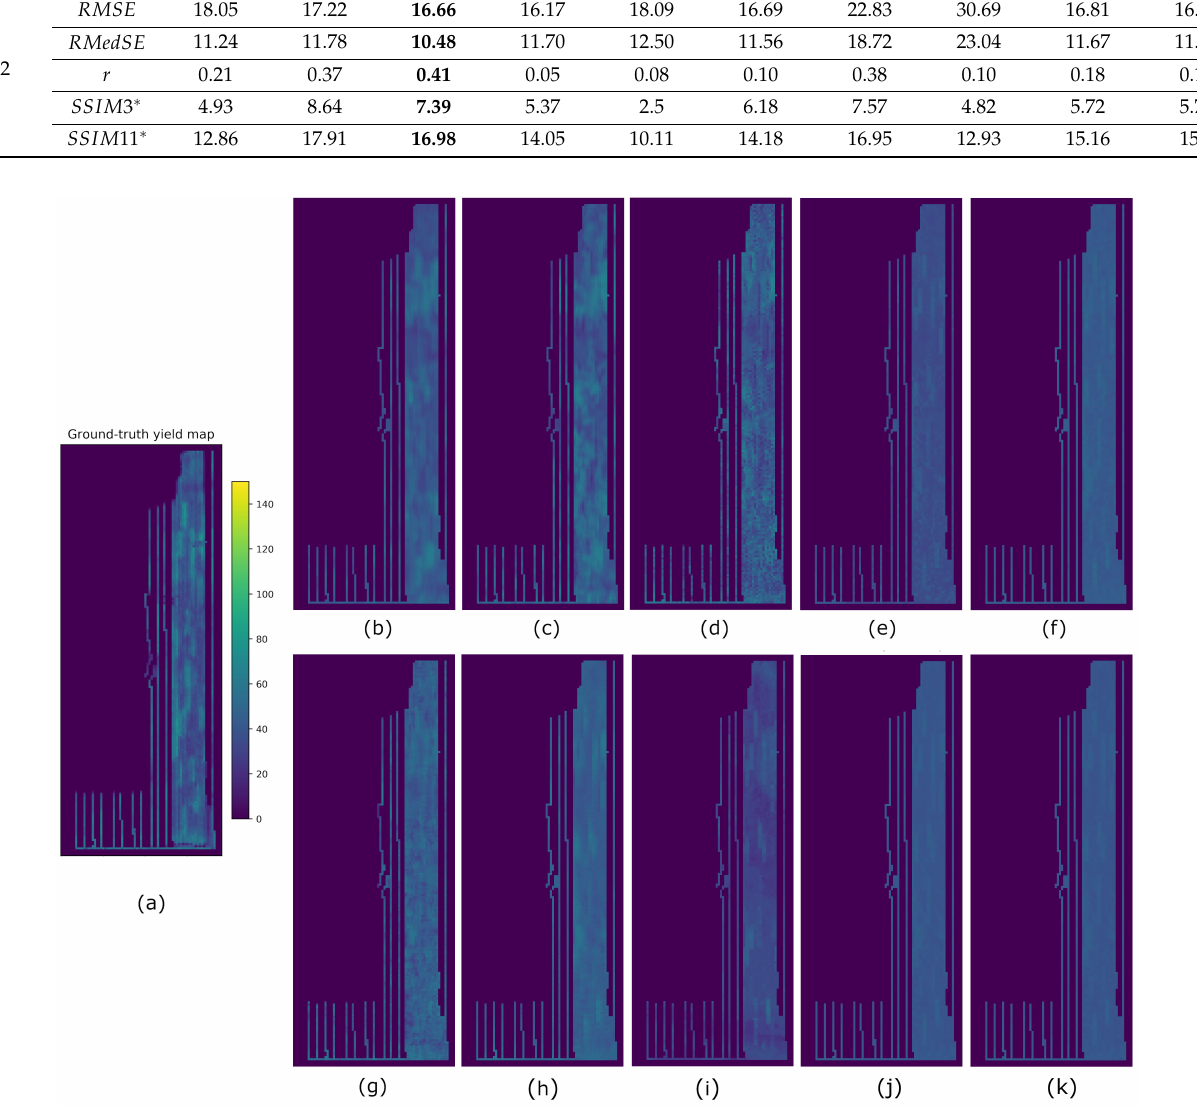
Figure 7. Yield prediction comparison on the F1 field using split A. ( a ) Ground-truth. ( b ) Hy- per3DNetReg ( N = 5). ( c ) Hyper3DNetReg ( N = 3). ( d ) Hyper3DNetReg ( N = 1). ( e ) Ad- aBoost.App. ( f ) SAE. ( g ) 3D-CNN. ( h ) CNN-LF. ( i ) RF. ( j ) BMLR. ( k )